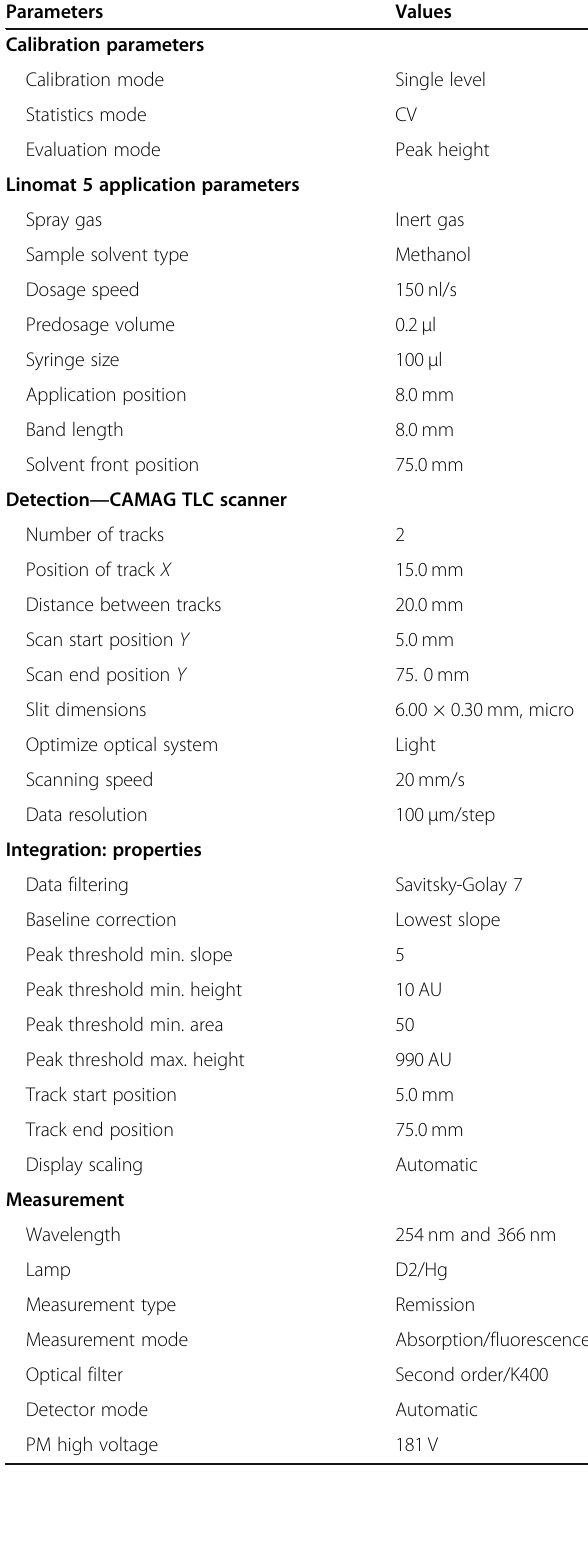
Table 2 Parameters used for